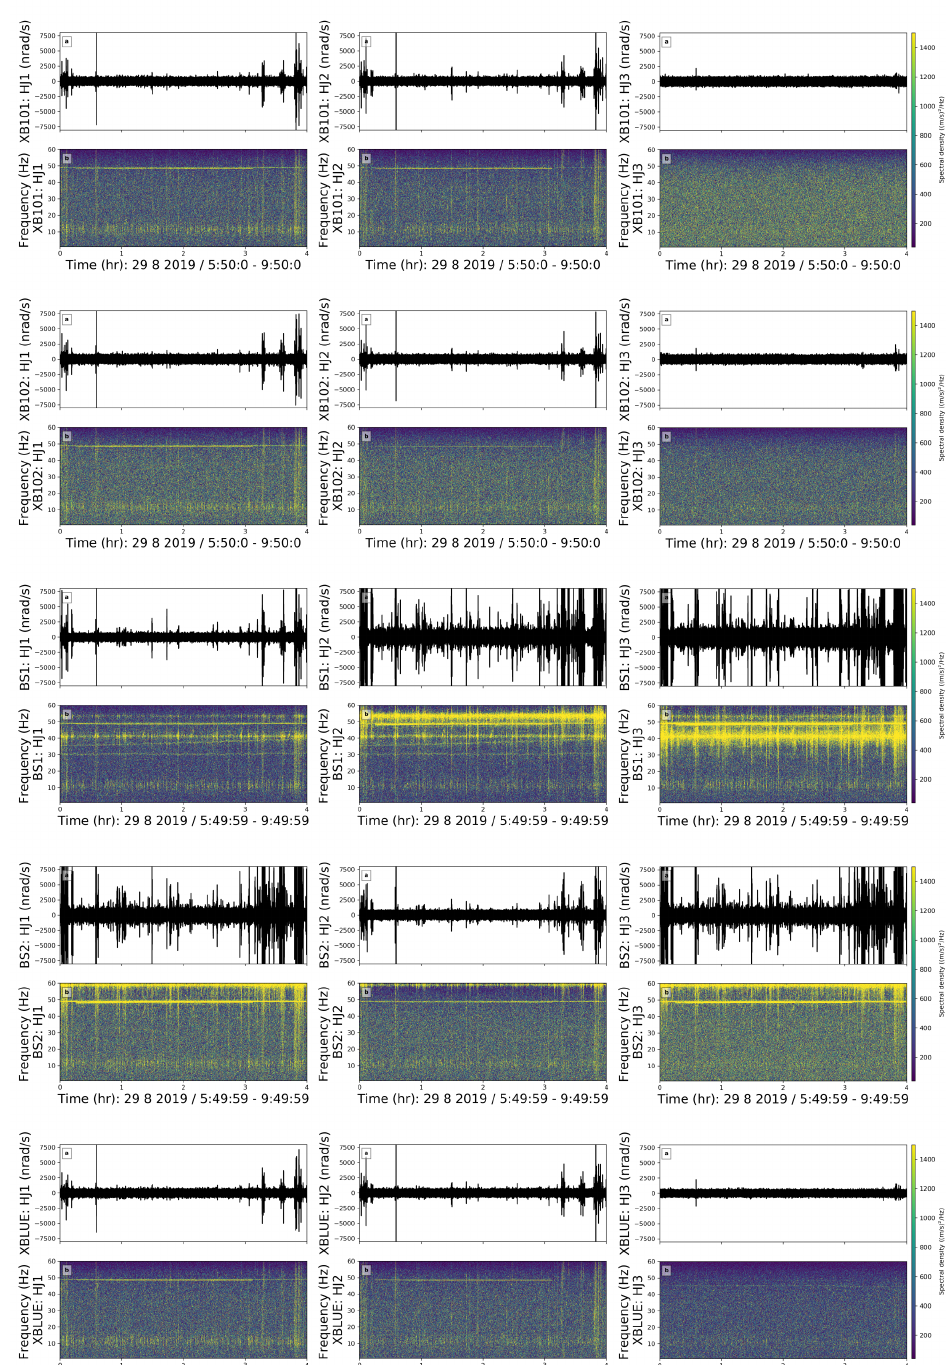
Figure 6. Long-lasting noise source. ( a ) Waveforms and ( b ) Spectrograms of the East, North and vertical components (left, middle, right column) of the XB101, XB102, BS1, BS2, XBLUE sensors from top to bottom for 4 h on doy: 241, i.e., 29 August, Thursday, respectively. Yellow and blue colours indicate higher and lower spectral densities,